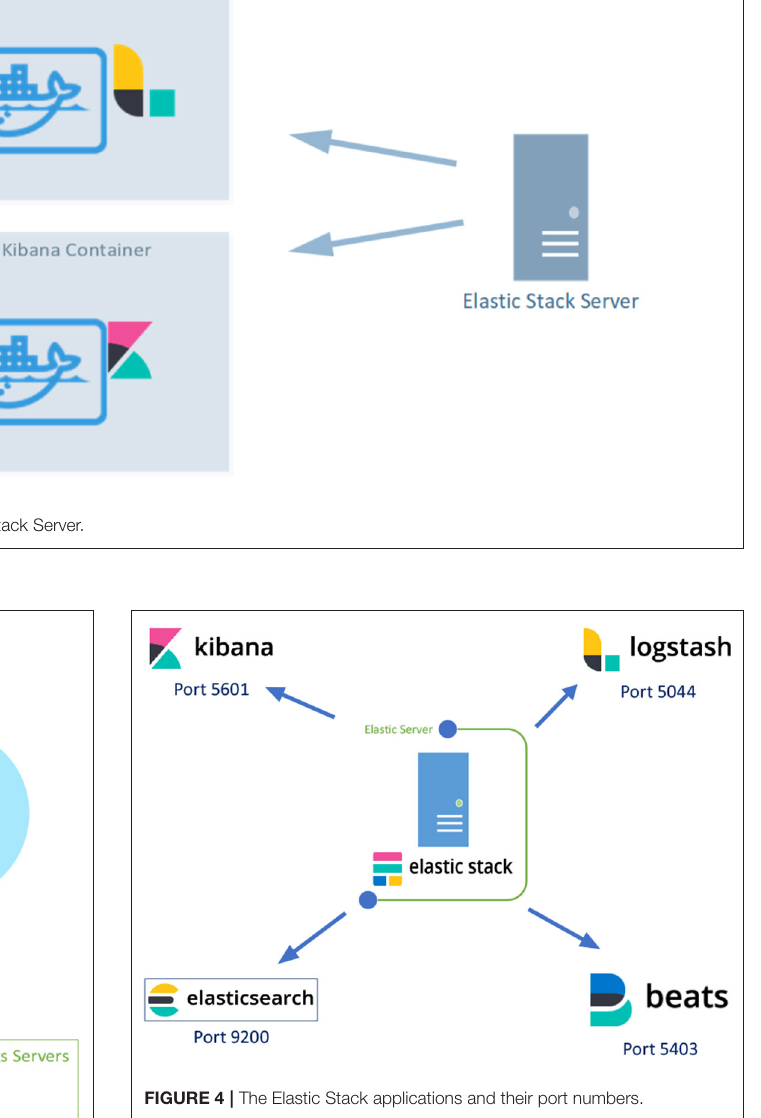
Elasticsearch configuration includes several